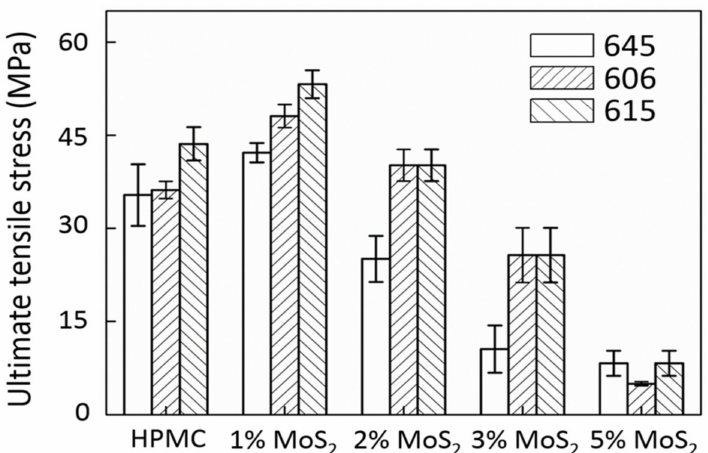
Figure 3. UTS results of MoS 2 /HPMC composites.